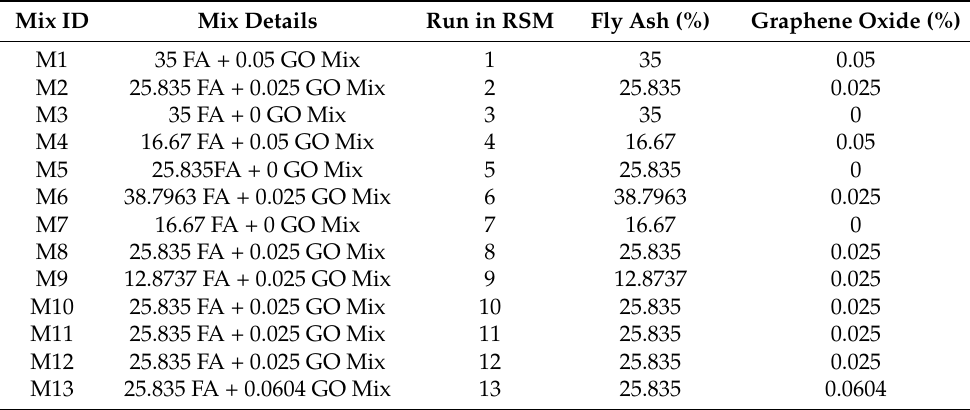
Table 5. Experimental combinations obtained by Design Expert software.